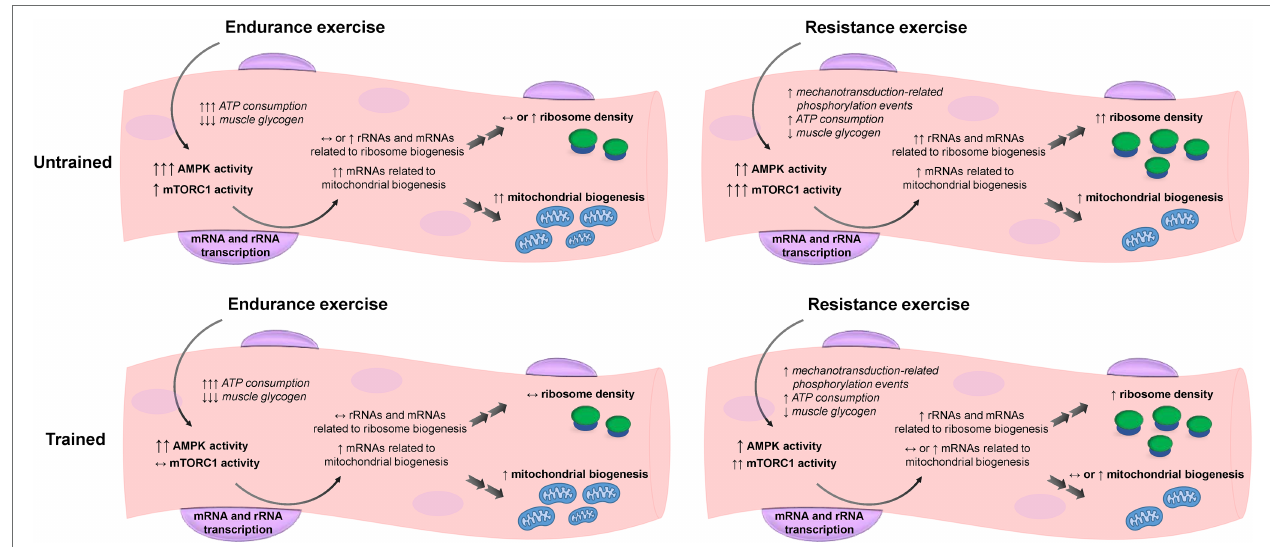
FIGURE 1 | Hypothetical representation of ribosome and mitochondrial biogenesis and the respective signaling responses to endurance and resistance exercise in untrained and trained states. Untrained individuals present a more generic response to exercise, with increases in both 5 ' AMP-activated protein kinase (AMPK) and mechanistic target of rapamycin complex 1 (mTORC1) signaling with either endurance or resistance exercise, which may ultimately lead to a concomitant increase in ribosome and mitochondrial biogenesis. Upon training, the signaling responses to exercise seem to be attenuated and mitochondrial biogenesis is prioritized with endurance training, while ribosome biogenesis is prioritized with resistance training. Note that even in trained subjects, AMPK exhibits a more generic response to exercise compared to